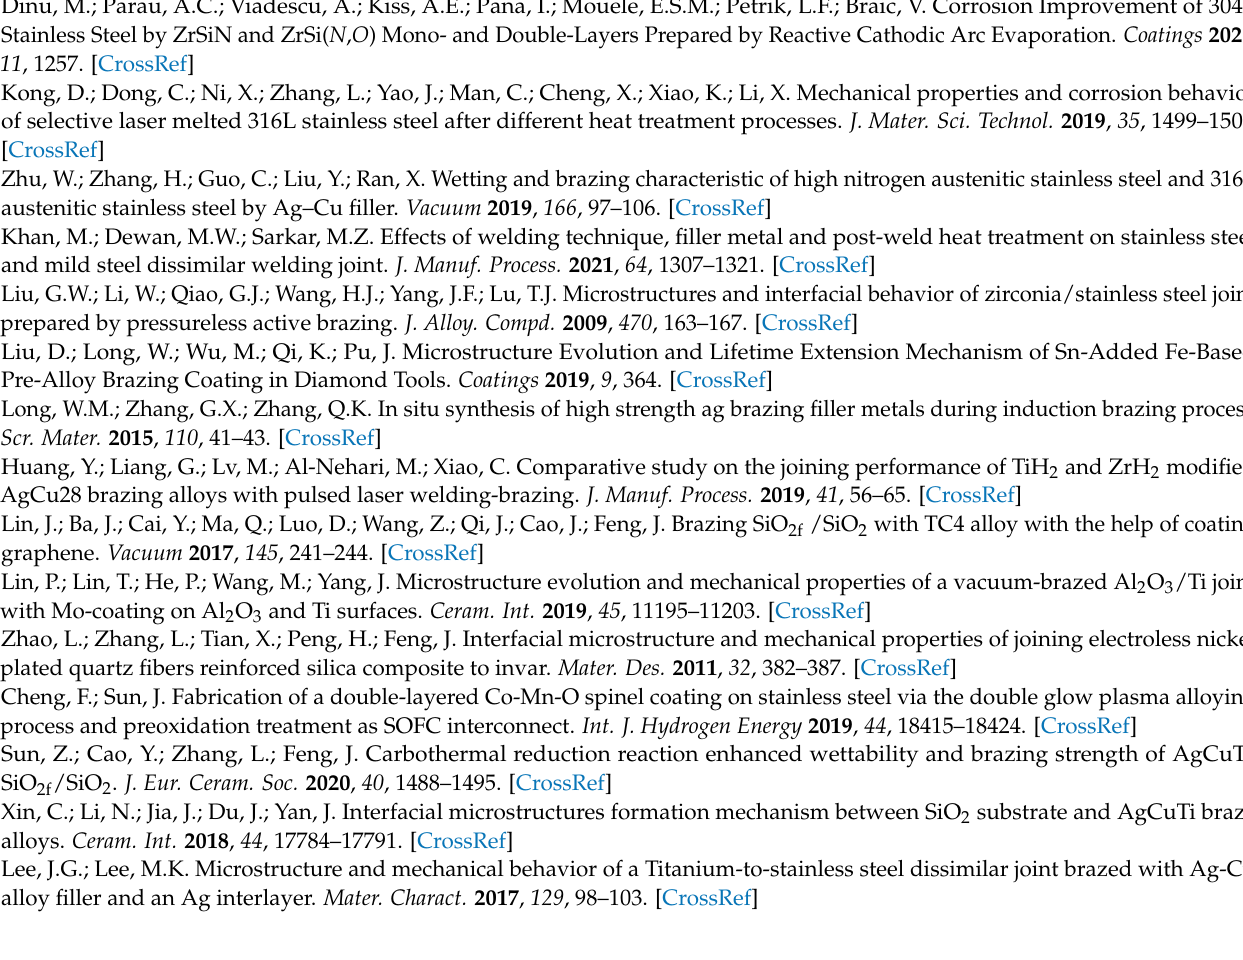
brazing alloy; Figure S2: Characterization of 1Cr18Ni9Ti base substrates without surface treatment. (a) Two-dimensional AFM image, (b) Three-dimensional AFM image, (c) EDS results, and (d) XRD spectra; Figure S3: AFM images of 1Cr18Ni9Ti base substrates after surface treatment. (a,c) Acid treatment and (b,d) acid treatment + 4 µ m